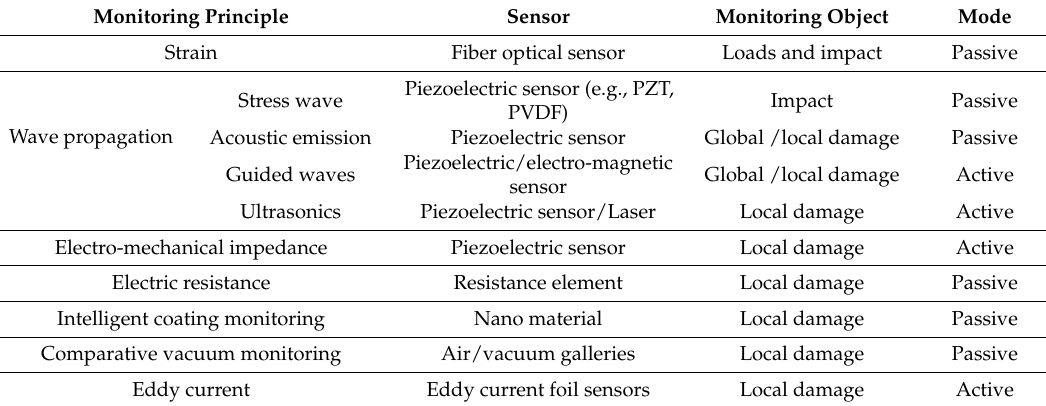
Table 2. SHM technologies commonly used in